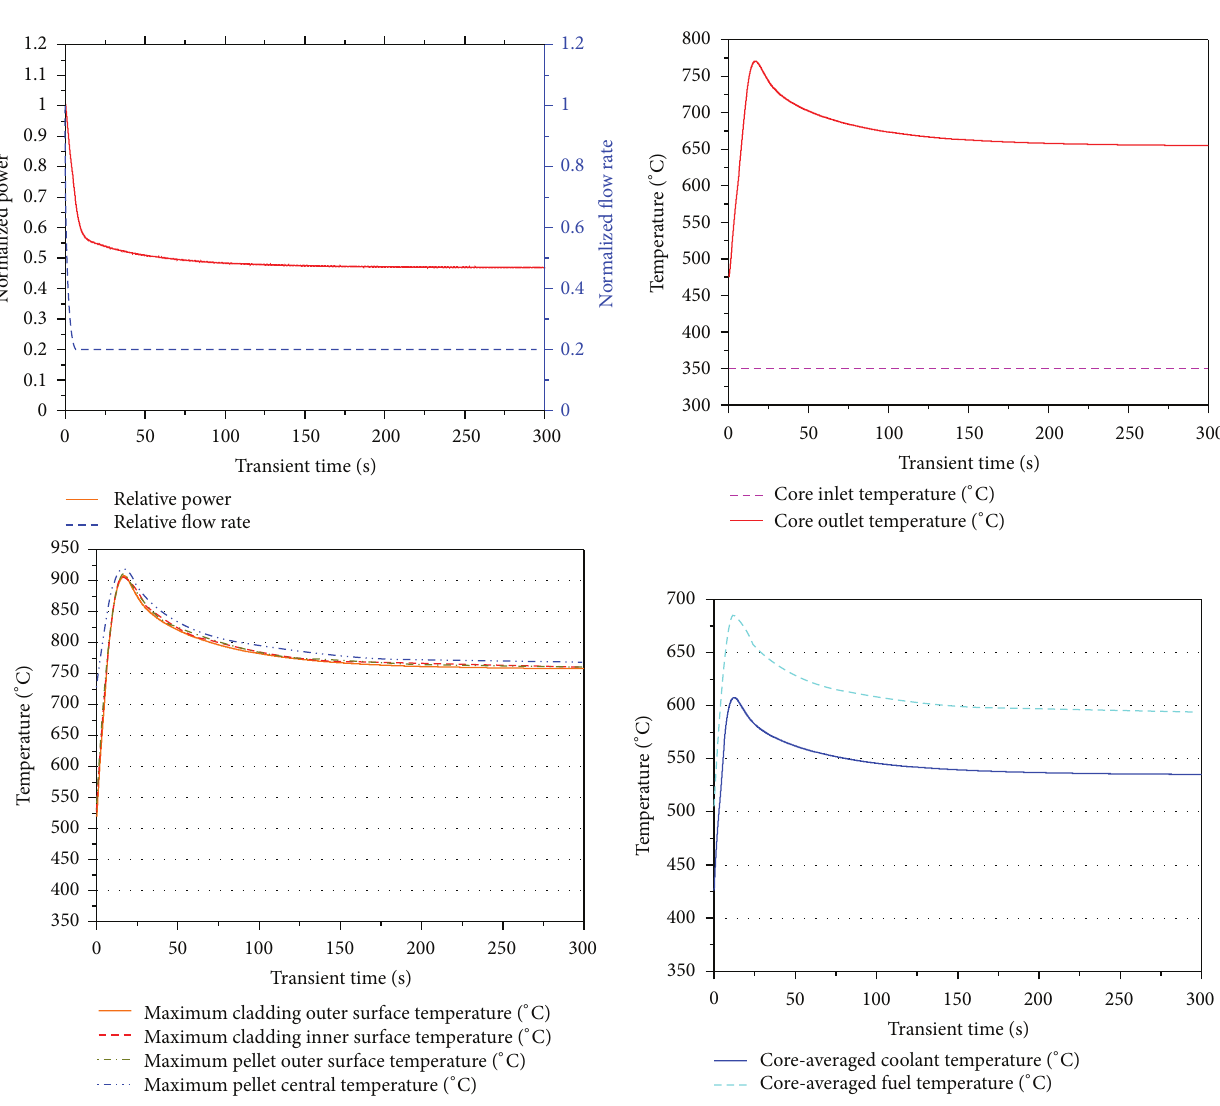
Figure 20: Core key parameters response during